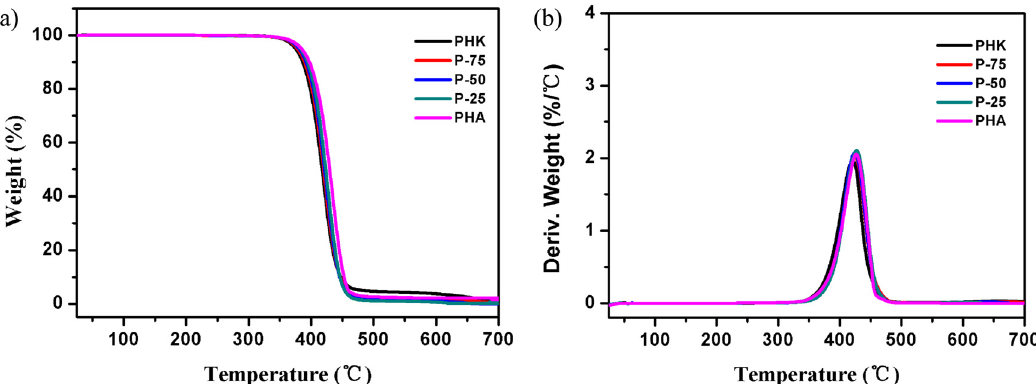
Figure 4: TGA curves ( a ) and derivative curves ( b ) of PHK, PHA, and poly ( HK - co - HA ) copolymers with a heating rate of 10°C min − 1 .